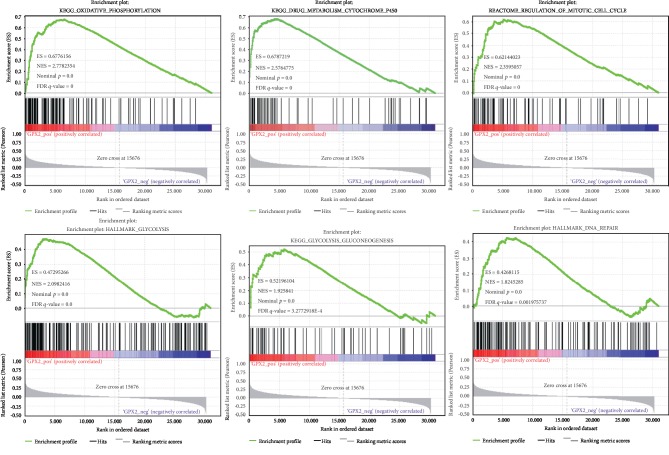
Gene set enrichment analysis (GSEA). GSEA showed that high expression of GPX2 is positively correlated with an oxidative phosphorylation gene set, a drug metabolism cytochrome P450 gene set, a reactome regulation of mitotic cell cycle gene set, a hallmark glycolysis gene set, a glycolysis and gluconeogenesis gene set, and a hallmark DNA repair gene set.